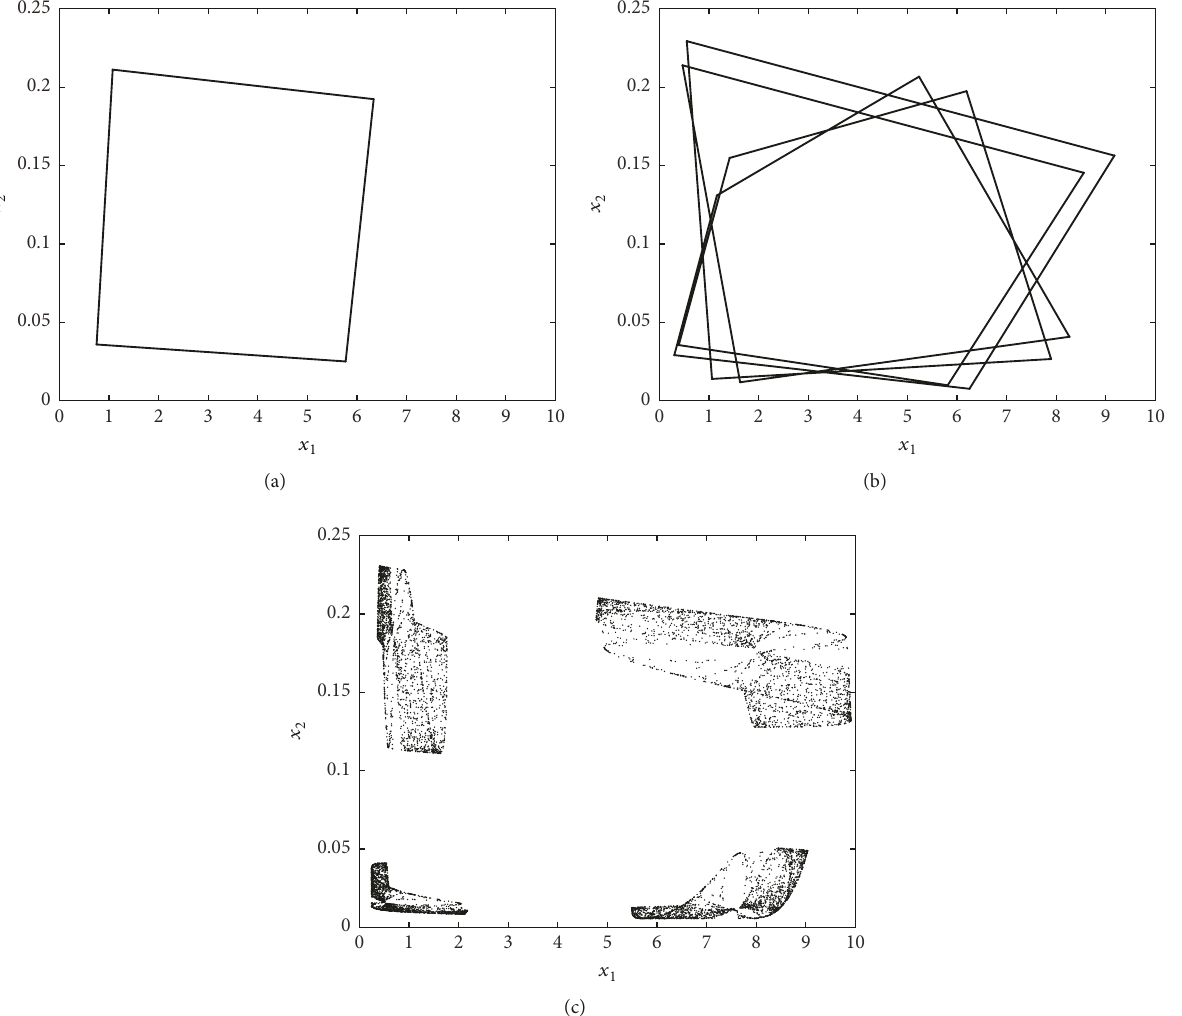
Figure 3: (a) A 4 -periodic orbit generated by map (19). 𝛾 = −0.1 , (𝑃,𝐹) = (0.6, 30) . (b) A 16 -periodic orbit generated by map (19). Parameter values as in (a), except 𝐹 = 40 . (c) Chaotic dynamics generated by map (19). The attractor is divided into 4 subsets which are visited once every fourth iteration. Parameter values as in (a), except 𝐹 = 43